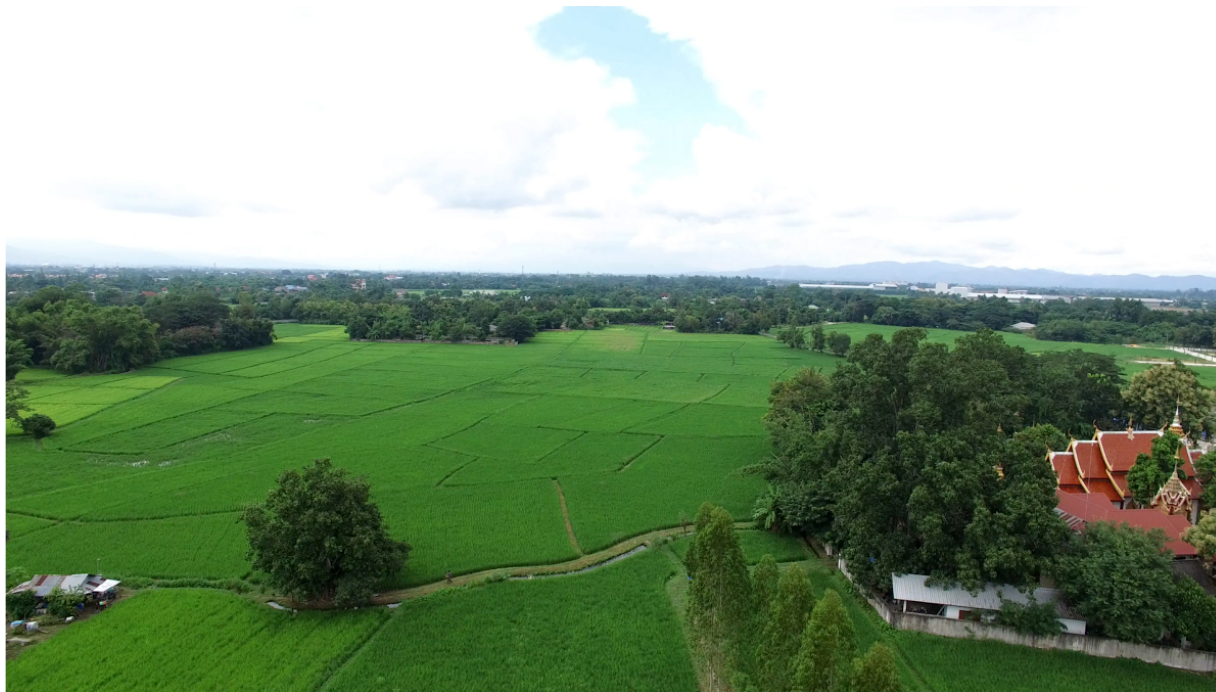
Figure 11. Wet rice paddies and secondary irrigation canals just north of the weir in Figure 12, all within the low density res- idential zone of the comprehensive plan. Wat Tha Thum is to the right. Drone imagery: Santipab Sonboom, October